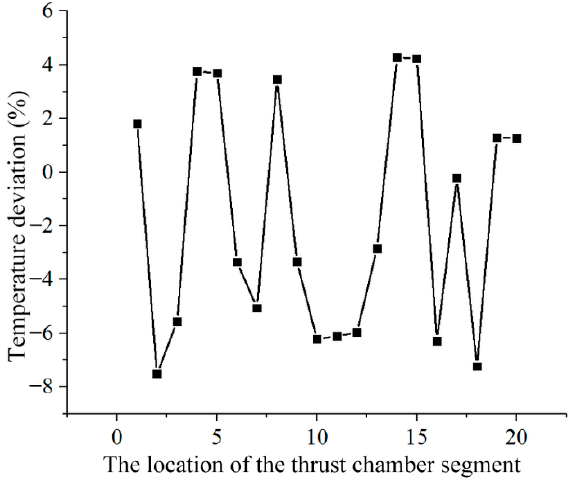
Figure 4. Gas wall temperature deviation by the one-dimensional preliminary calculation.